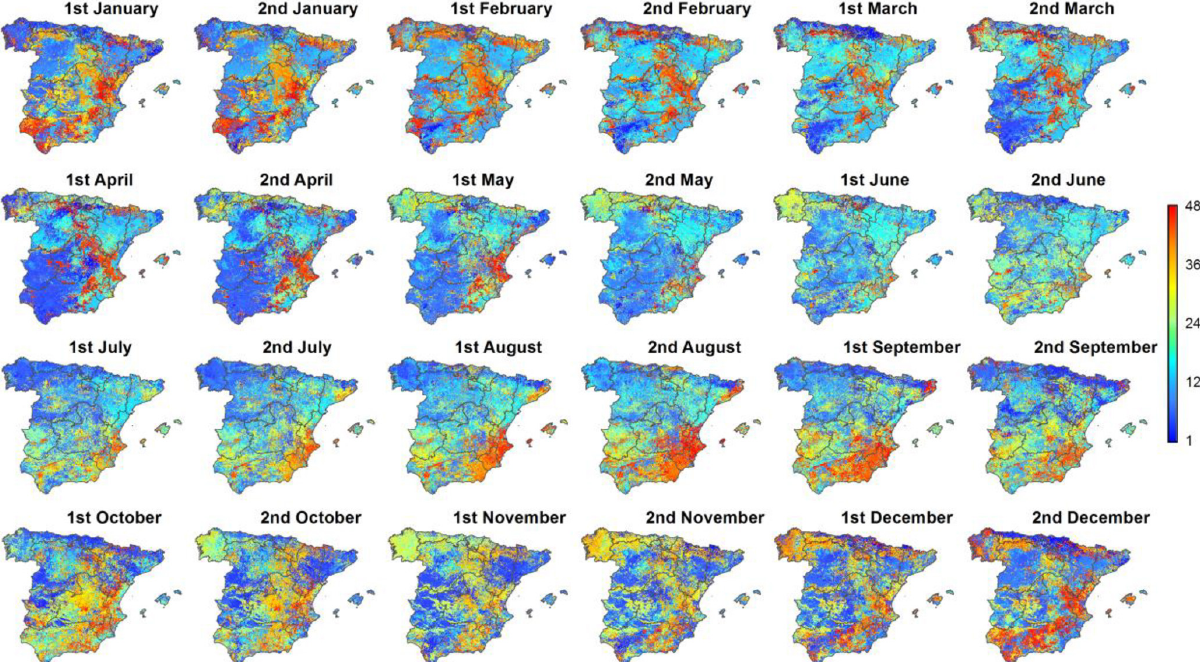
Figure 4. Spatial distribution of the SPEI timescales at which the maximum correlation between the sNDVI and SPEI is found for each one of the semi-monthly periods.